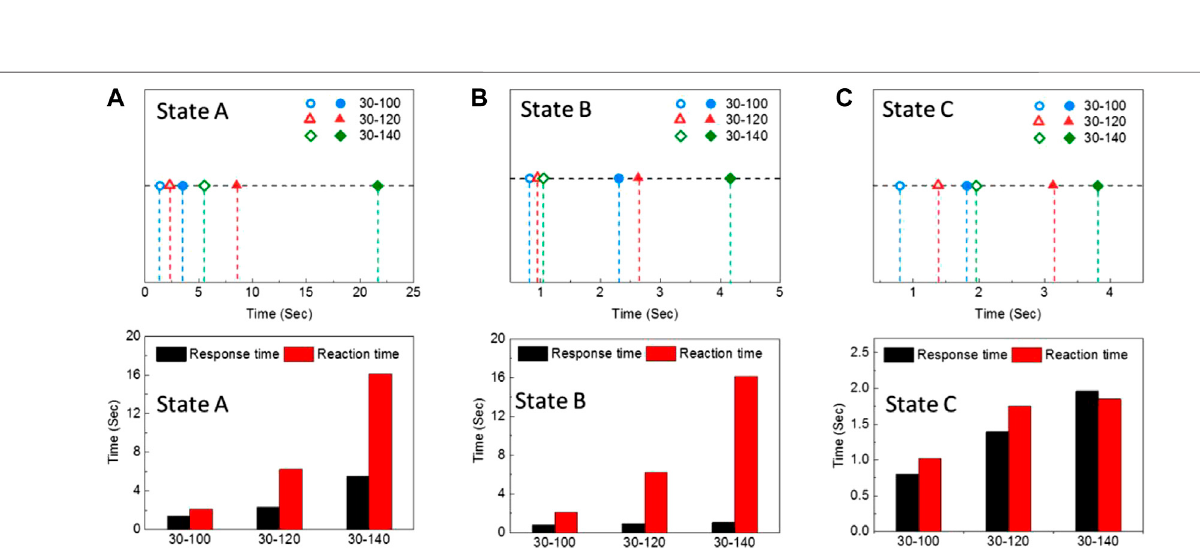
Frontiers in Materials |